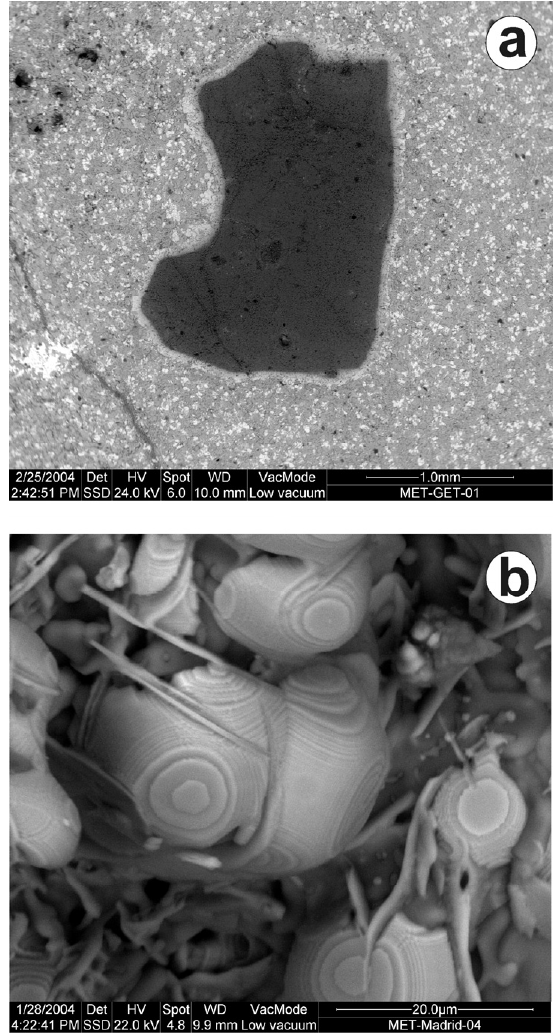
Fig. 4 – Selected images from the ESEM analyses: (a) Magnesite (MgCO 3 ) grain and (b) Hematite (Fe 2 O 3 ) spherical crystals; note the hexagonal shapes along the c axis.